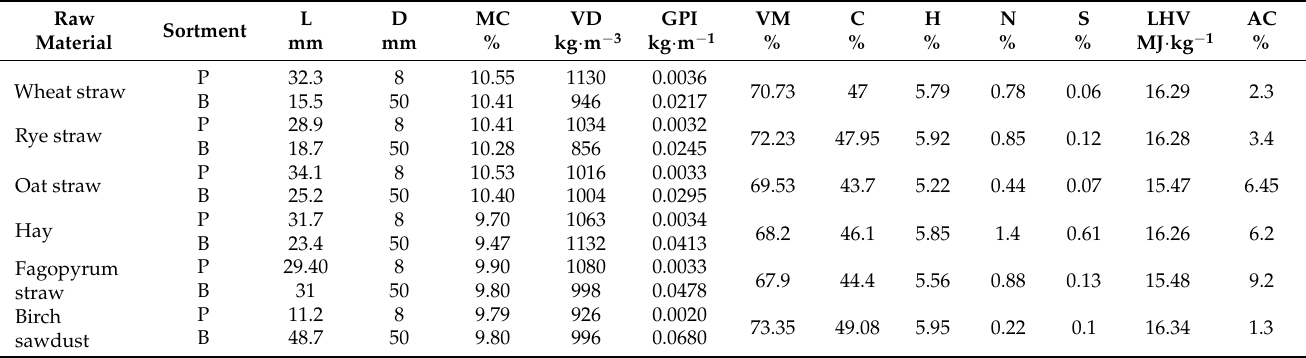
Table 1. Selected physical and chemical properties of produced pellets and briquettes.